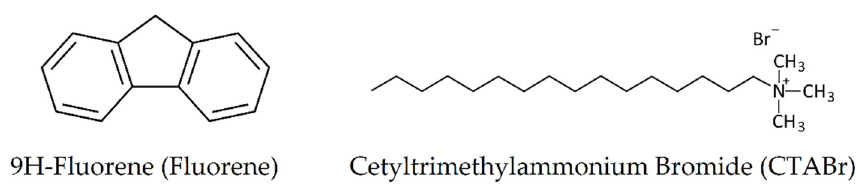
Figure 1. Molecular formulas of used chemical compounds .